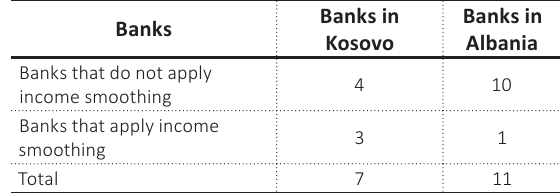
Table 2. Number of banks in Kosovo and Albania